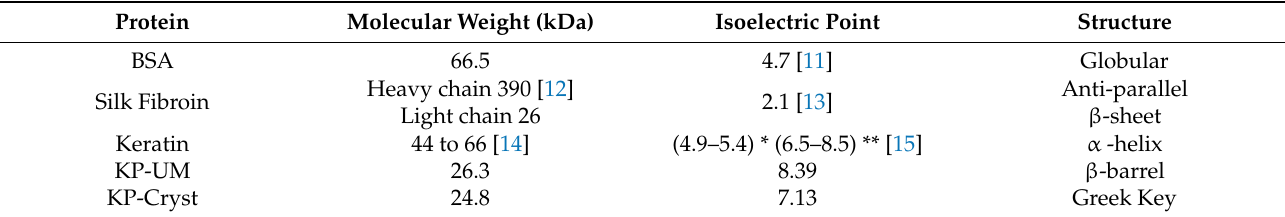
Table 1. Molecular weight, isoelectric point and structure of bovine serum albumin (BSA), silk fibroin, keratin, KP-UM and KP-Cryst proteins. Protein Molecular Weight (kDa) Isoelectric Point